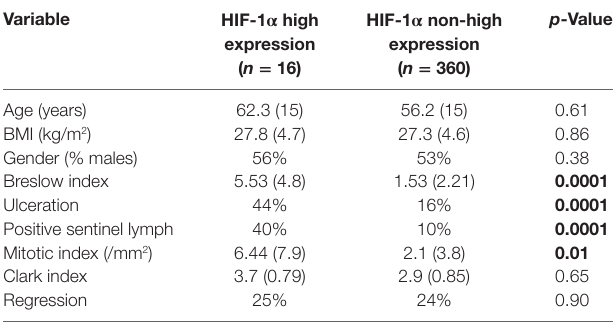
TaBle 5 | Comparisons between the groups with high and low expression of hypoxia inducible factor (HIF)-1 α regarding their general characteristics and aggressiveness markers of melanoma.